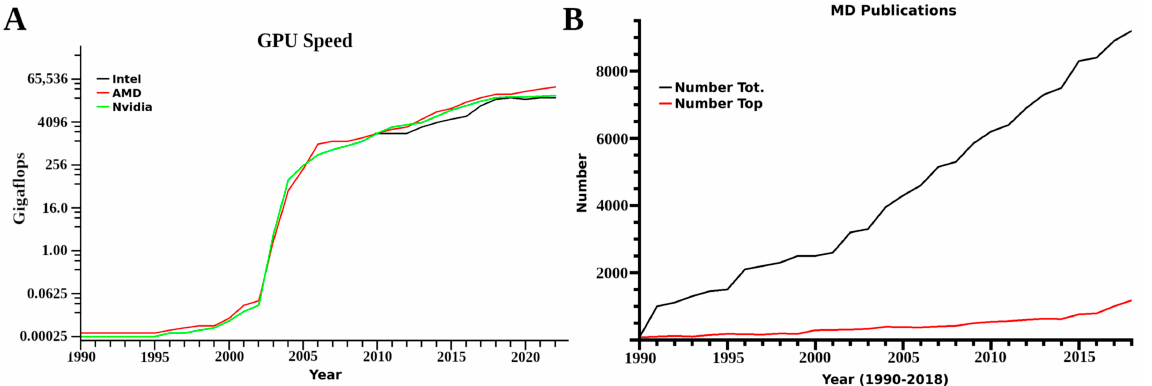
Figure 1. Change over time in computer speed and MD publications. ( A ) Change in speed for AMD, Nvidia and Intel Graphics processing units. Intel only began competing in the market in 2010 with non ‐ embedded processors (black). Prior to the year 2000, Nvidia and AMD precursors companies are used, consolidated after 2000. ( B ) Increase in published MD work, with total publications (black) and top journals (red) compared. Data from authors own company price searches by year, literature searches by year, and ref. [1].